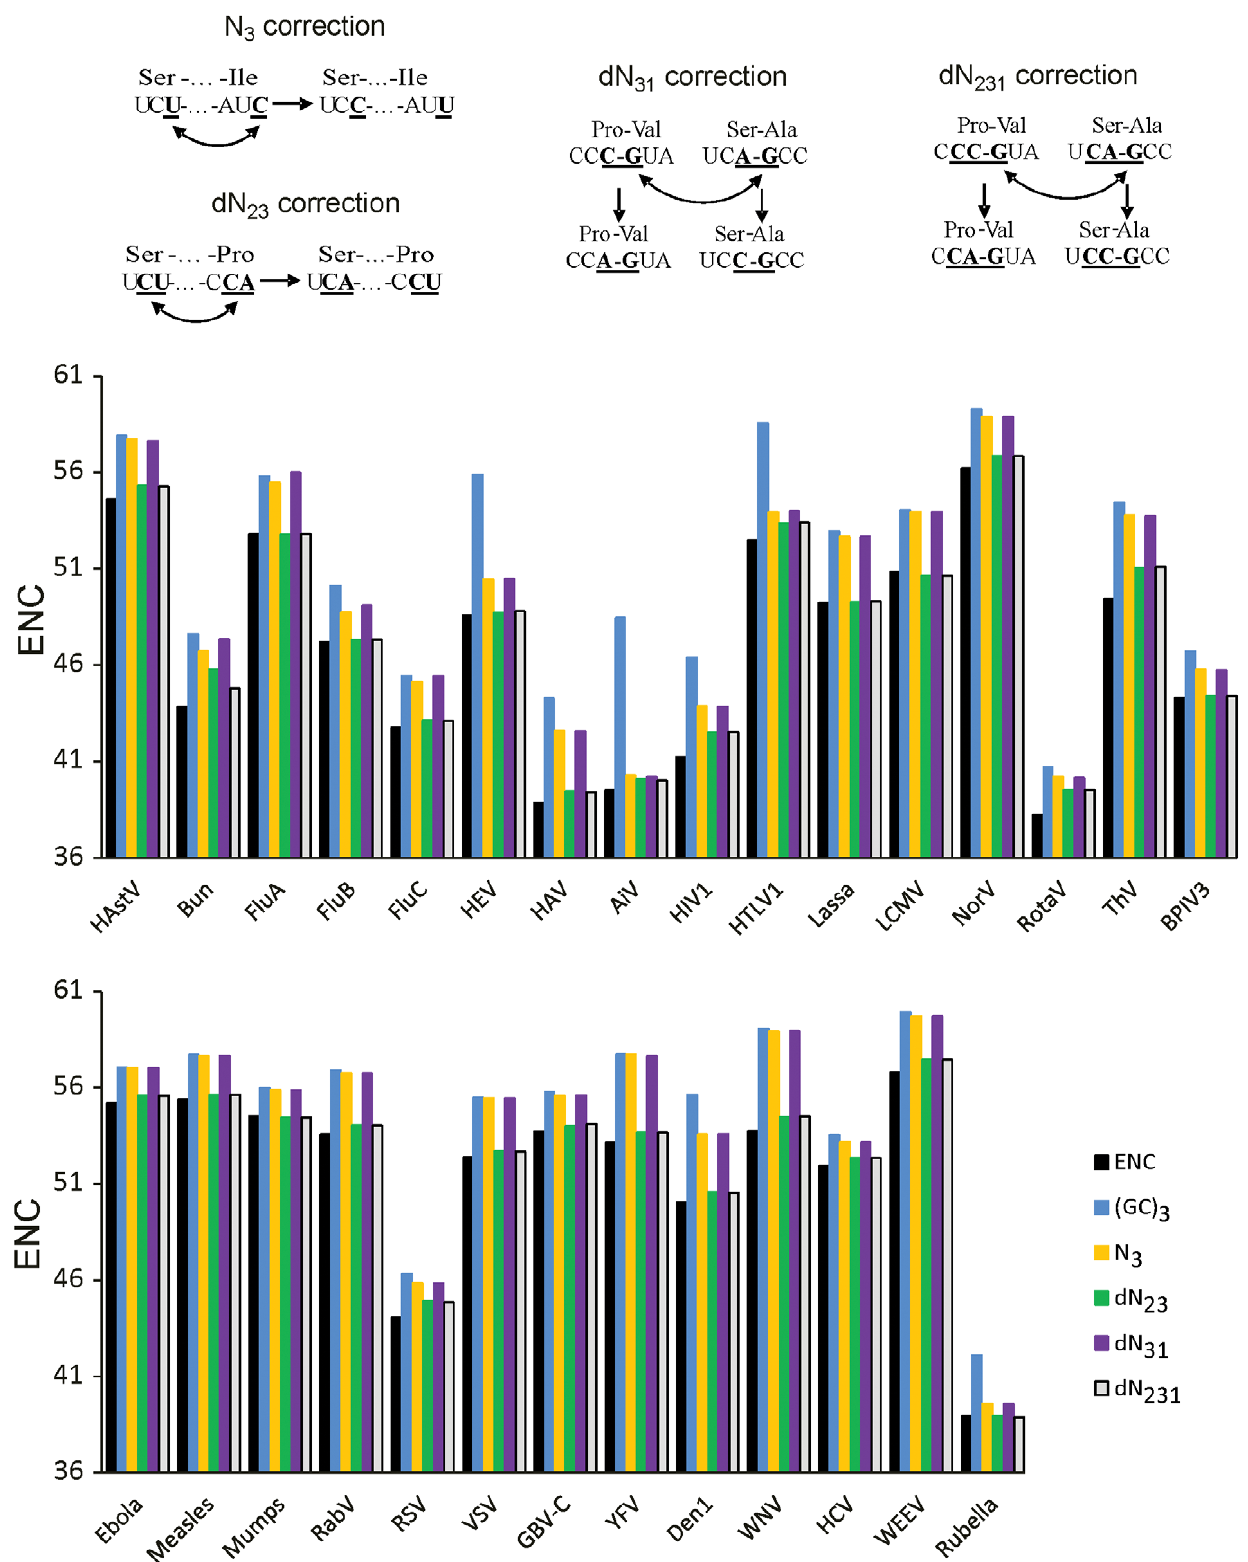
Figure 1. Effective number of codons in the original and shuffled sequences. (A) Explanation of shuffling algorithms. (B) Effective number of codons in the original virus sequence and the mean ENC of 1000 sequences randomized or scrambled using different algorithms. Virus name acronyms are provided in Table 1.